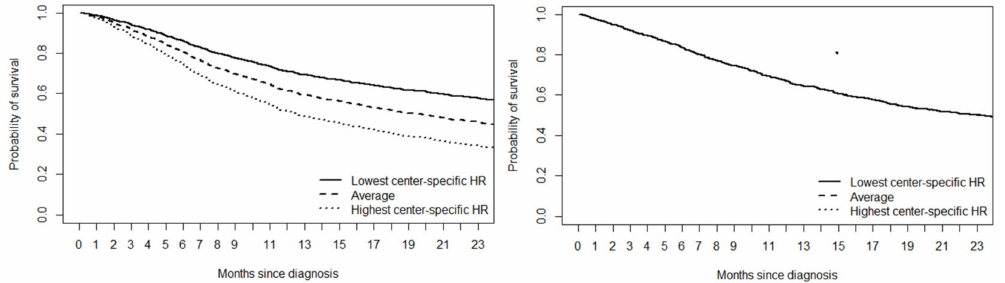
Figure 3. Model III-based predicted survival curves of patients diagnosed in 2014 (left) and 2016 (right) with the following characteristics: 80-year-old male, with 1 × elevated LDH, ECOG PS of ≥ 2 with 0–2 organ sites, no liver or brain metastases, BRAF wild-type tumor, who would be treated in the centers with the highest, lowest, and average HR in the dataset. HR = hazard